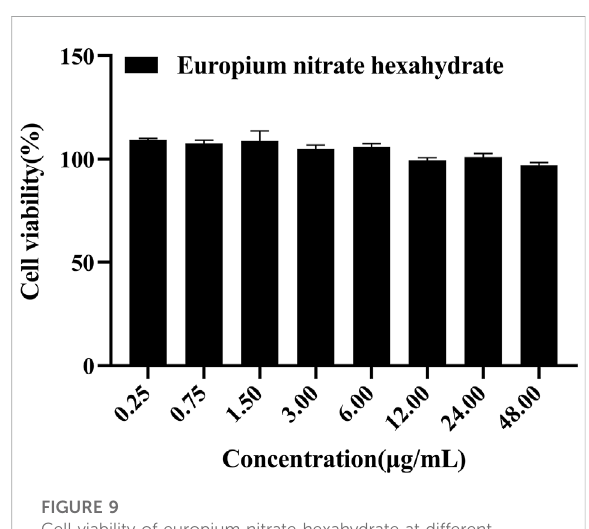
FIGURE 9 Cell viability of europium nitrate hexahydrate at different concentrations on A549 cells (0.25, 0.75, 1.5, 3, 6, 12, 24, and 48 μ